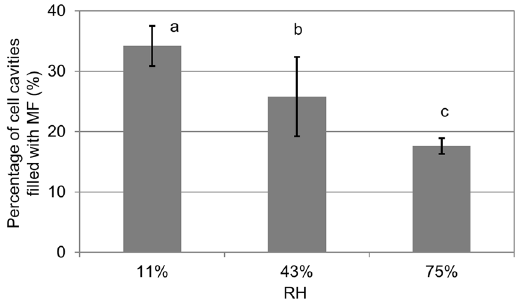
Figure 4. Percentage of cell cavities filled with MF as evaluated from the cryo-TOF-SIMS images in Fig. 3. The bars indicate the standard deviation from five replicates. Different letters indicate significant differences ( P <